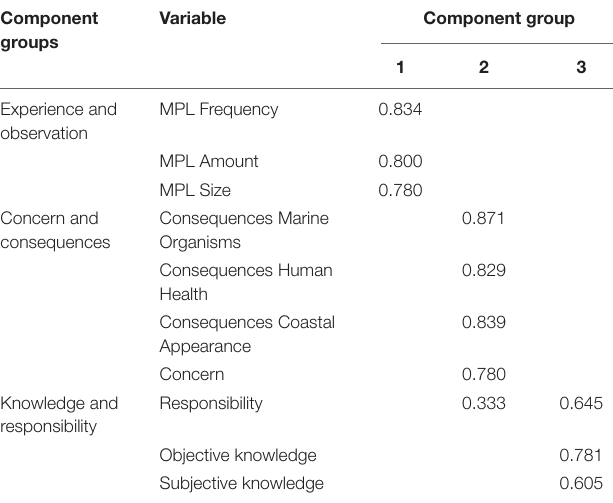
TABLE 1 | Rotated component matrix suggesting three factor groups.